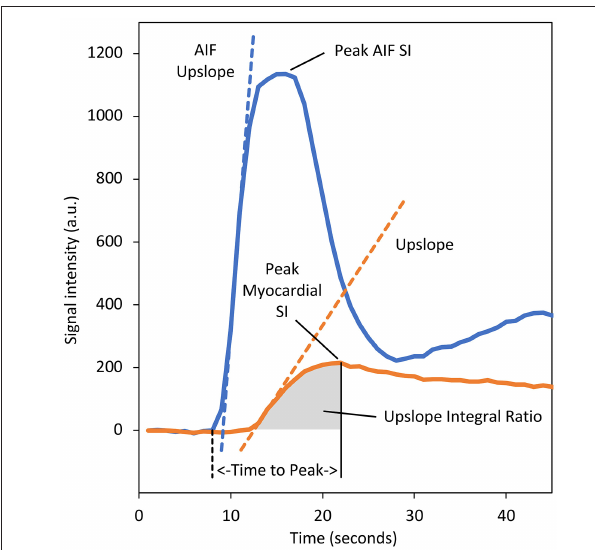
FIGURE 3 | Baseline corrected signal intensity (SI)–time curves for myocardial tissue (orange) and the arterial input function (AIF) (blue) sampled from the left ventricular (LV) blood-pool. Various semi-quantitative perfusion parameters are demonstrated. The dashed orange line represents the “upslope” parameter and denotes the maximal rate of myocardial contrast enhancement. Division of the myocardial upslope by the equivalent AIF upslope (dashed blue line) defines the “upslope index,” which normalises for the haemodynamic conditions and enables comparison between stress and rest, and calculation of a myocardial perfusion reserve index. The area under the myocardial tissue curve from the arrival of contrast at the myocardium to the time of peak enhancement defines the “upslope integral ratio.” The area under the myocardial curve from contrast arrival to the time of peak AIF enhancement has also been used to define this parameter. The “time to peak” myocardial enhancement is measured from the arrival of contrast in the LV blood pool (dashed black line) to the time of peak myocardial enhancement. The “contrast enhancement ratio” parameter is not displayed as this requires an uncalibrated baseline (defined as SI peak − SI baseline )/SI baseline (55). a.u., arbitrary